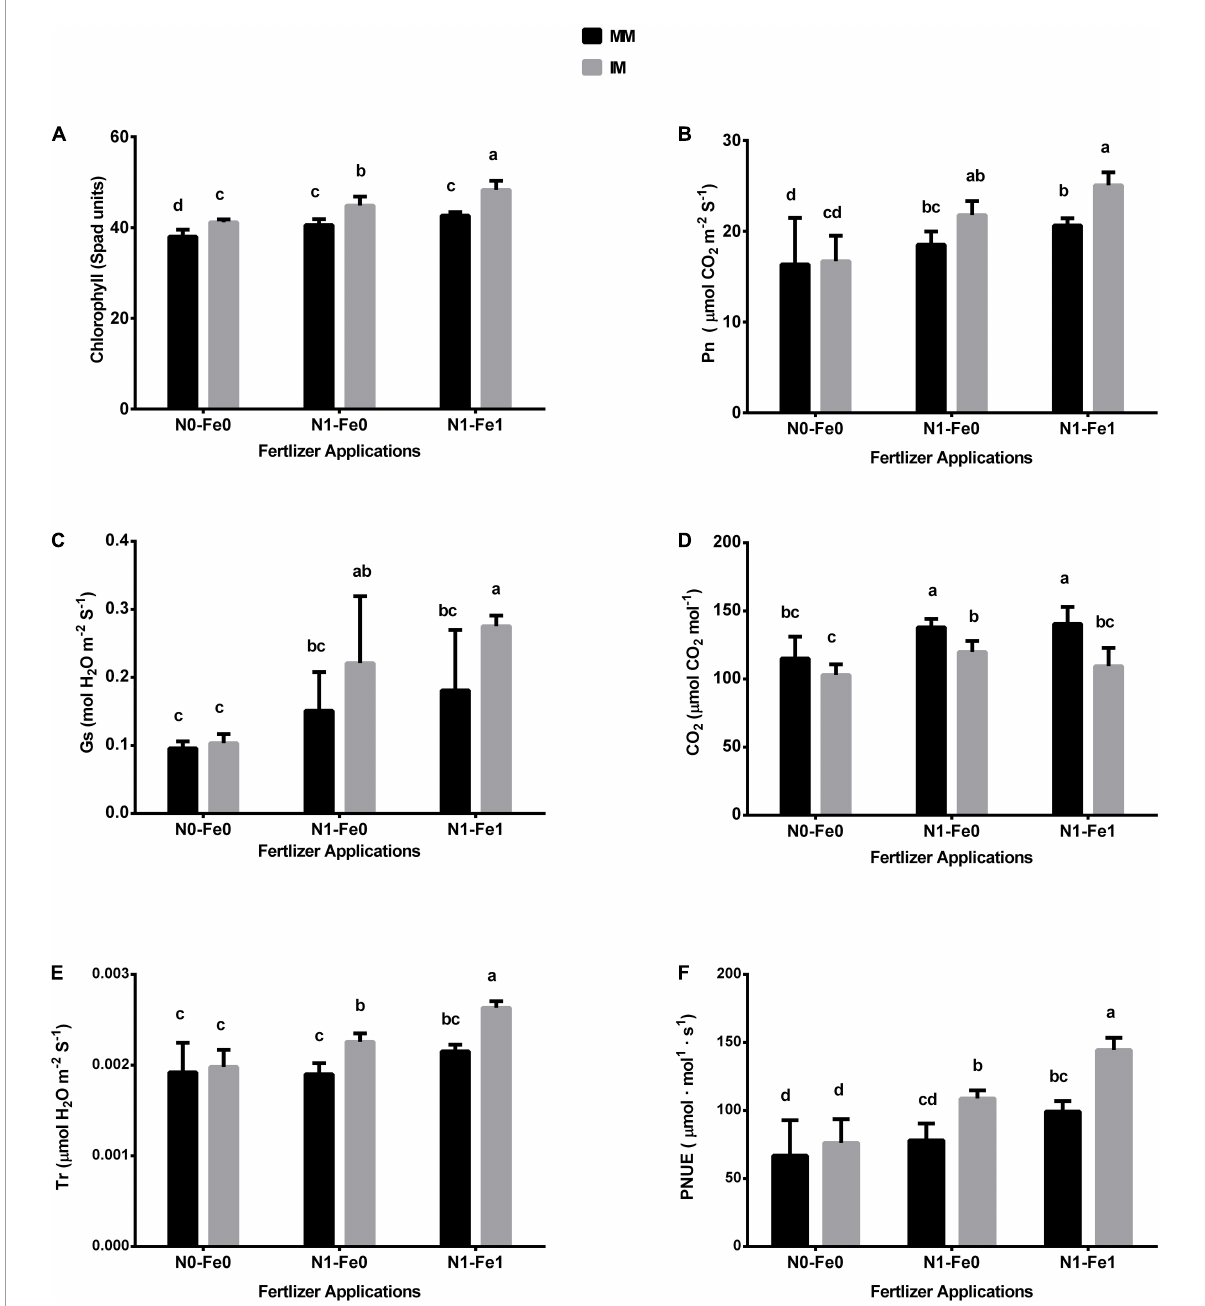
FIGURE3 Chlorophyll (A) , Pn (B) , Gs (C) , CO 2 (D) , Tr (E) , and PNUE (F) of the maize crops as influenced by different fertilizers and planting patterns. The column graphs with SD bars having dissimilar lower case letters are significantly different from each other at the LSD test ( p < 0.05). MM, maize mono-cropping; IM, maize intercropping; Pn, photosynthetic rate; Gs, stomatal conductance; CO 2 , intercellular carbon dioxide; Tr, transpiration rate; PNUE, photosynthetic nitrogen use efficiency; N0-Fe0, no nitrogen and iron fertilization; N1-Fe0, nitrogen fertilization without iron foliation; N1-Fe1, nitrogen fertilization with iron foliation.